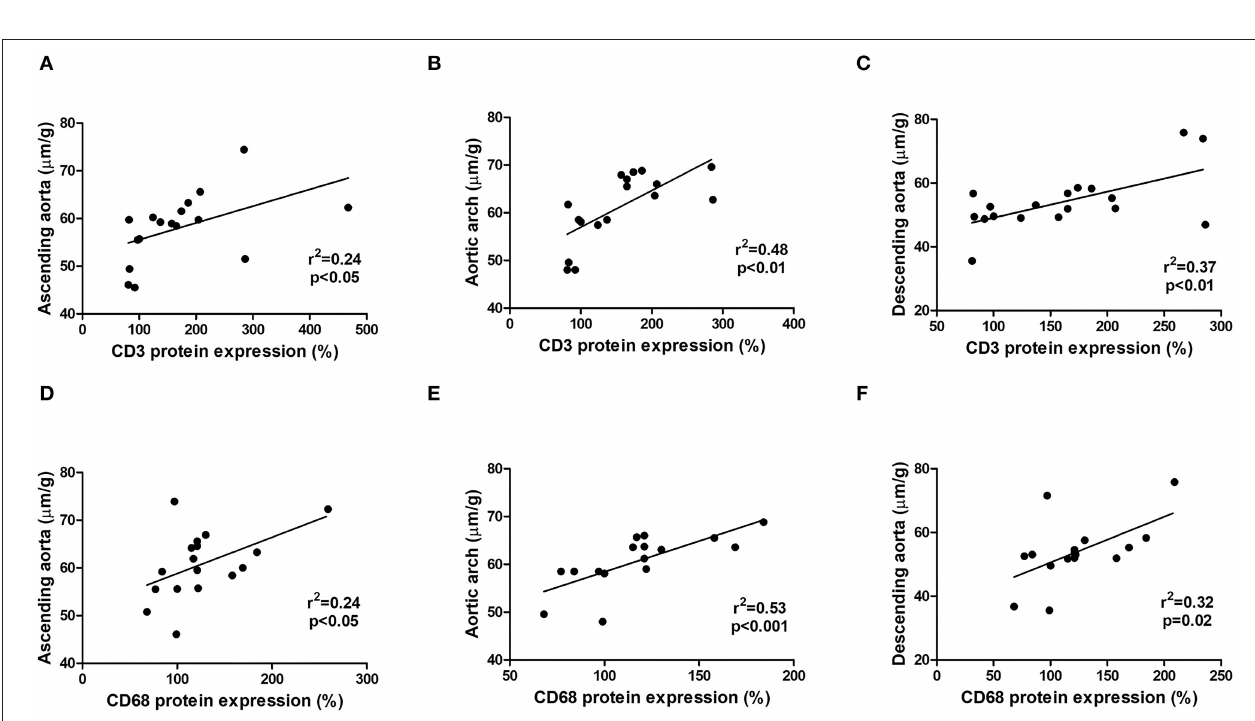
FIGURE 7 | Relationship between inflammatory cells CD3 (A–C) and CD68 (D–F) protein expression obtained by western blot and the dilation of the ascending aorta, aortic arch, and descending aorta obtained by echocardiography analysis in WT and MFS mice at 6 months of age, treated with LDE, MTX, and LDEMTX.